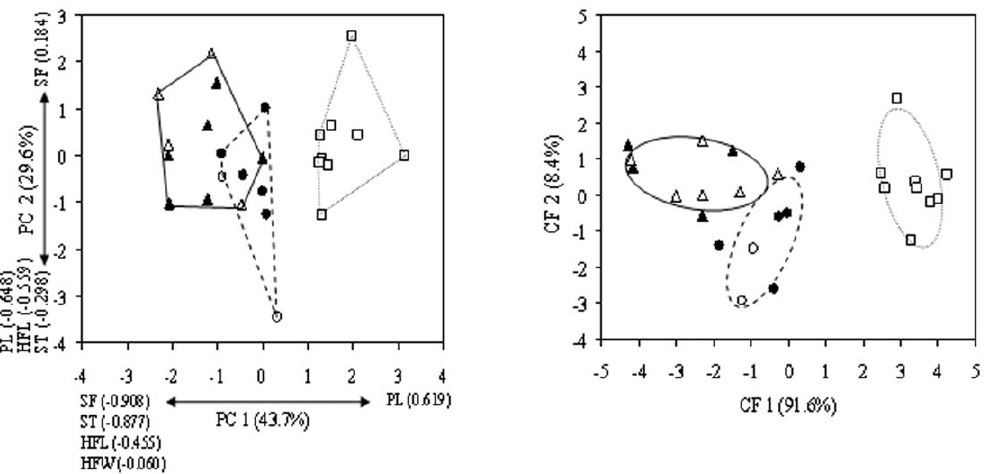
Figure 7. Comparative morphological analysis of Sagacampbellicampbelli,S.c.gracilis, and S.pedo shows clear differences. Labels: D - S. c. campbelli, # - S. c. gracilis, and % - S. pedo . Open symbols represent females, whereas filled symbols indicate males. Panel A: Plots of scores along the first and second principal components for morphological characters. Variance proportions represented by each principal component are indicated together with the factor loadings (correlation). Panel B: Canonical analysis based on the three most important morphological characters (ST, HFW and SF) selected by the forward stepwise discriminant function analysis. Sexes were not distinguished in the analysis. Range ellipses are drawn around group centroids, and variance proportions represented by each canonical function are indicated. Abbreviations: CF – canonical function; PC – principal component. For additional abbreviations see the legend of Figure 5.